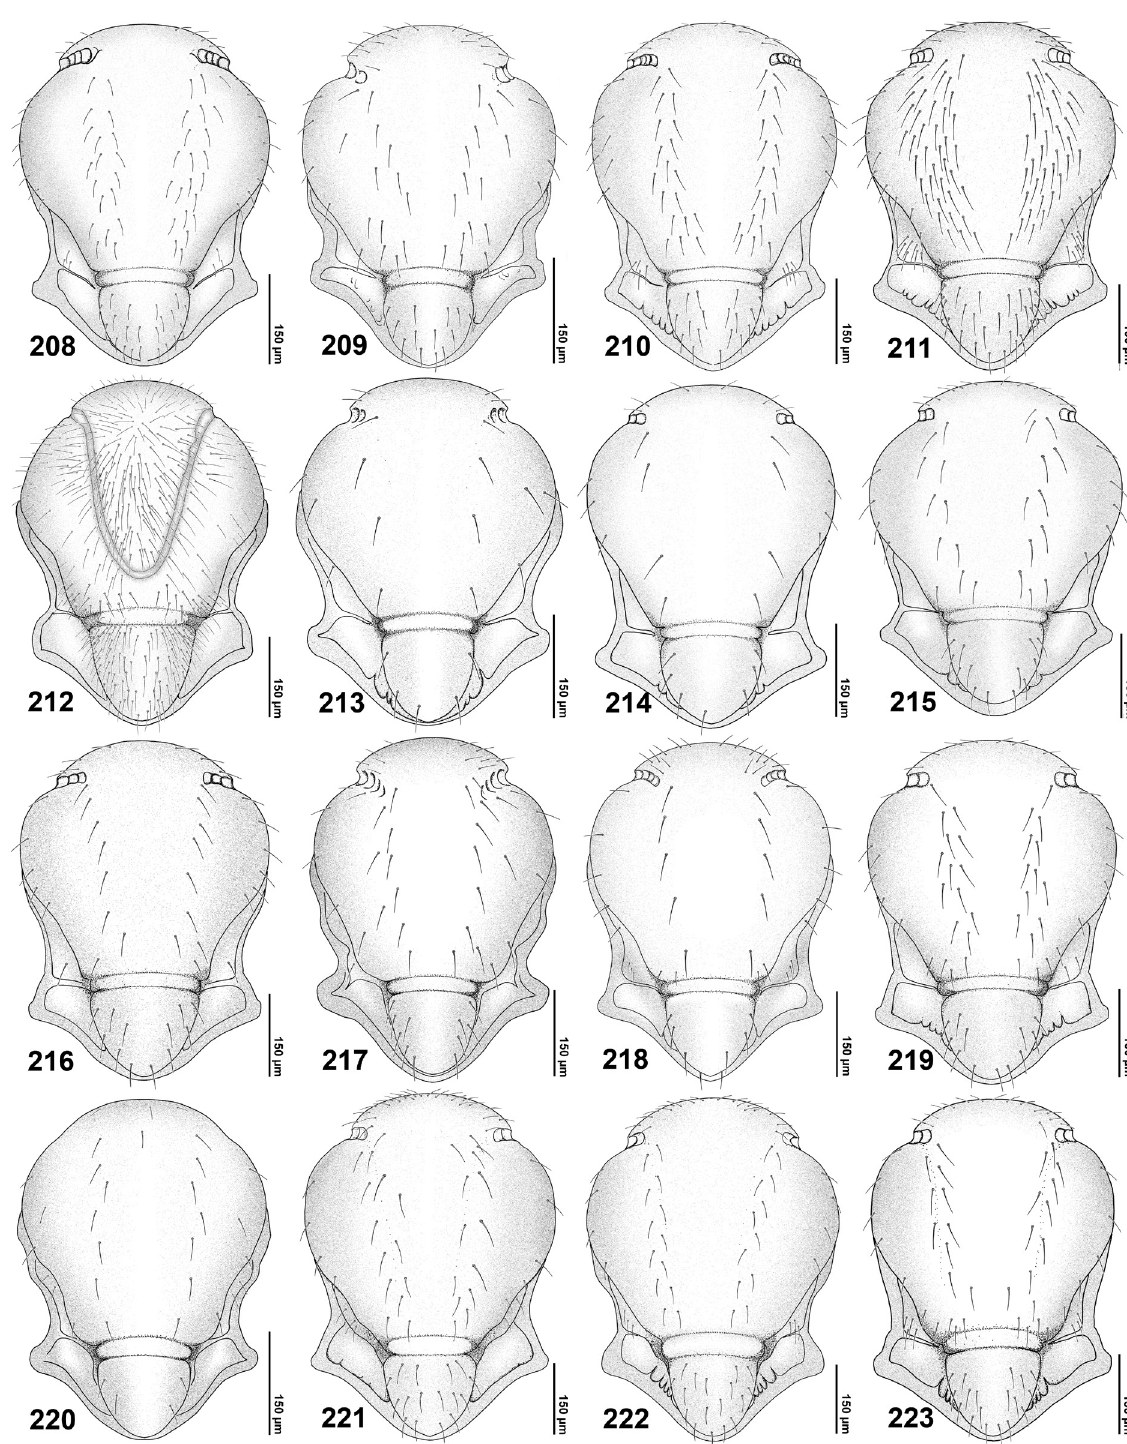
Figs 208–223. Dorsal aspect of mesonotum (♀): 208 . Aphidius transcaspicus . 209 . Aphidius uroleuci . 210 . Aphidius urticae . 211 . Aphidius uzbekistanicus . 212 . Areopraon lepelleyi . 213 . Betuloxys hortorum . 214 . Binodoxys acalephae . 215 . Binodoxys angelicae . 216 . Binodoxys brevicornis . 217 . Binodoxys centaureae . 218 . Binodoxys heraclei . 219 . Diaeretiella rapae . 220 . Diaeretus leucopterus . 221 . Ephedrus cerasicola . 222 . Ephedrus chaitophori . 223 . Ephedrus helleni 108